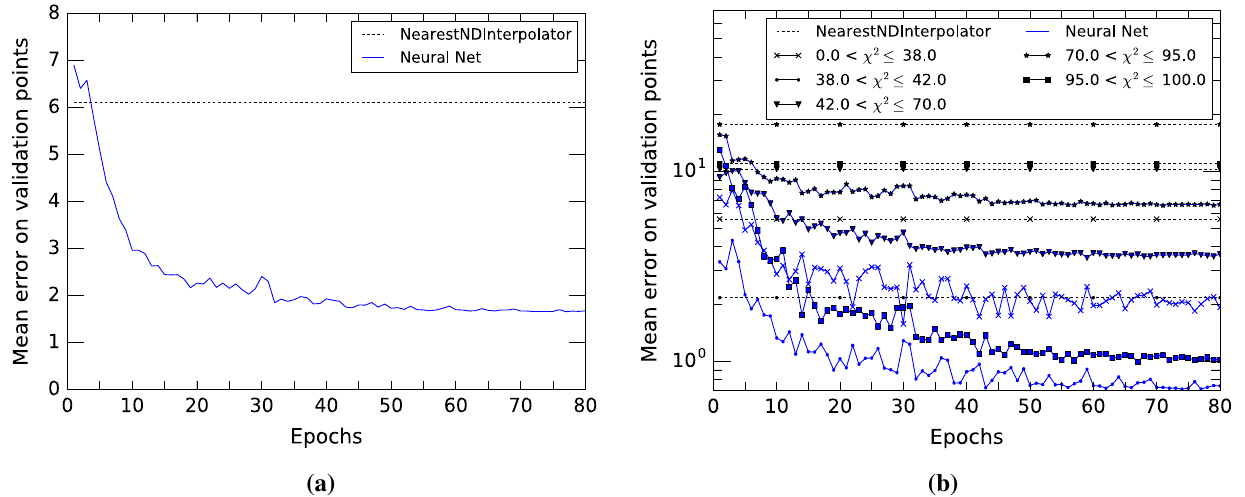
Fig. 5 Evolutionofthemeanerroronpointsinthevalidationsetduringtrainingonthe8TeVLHC χ 2 for all points ( a ), divided into different χ 2